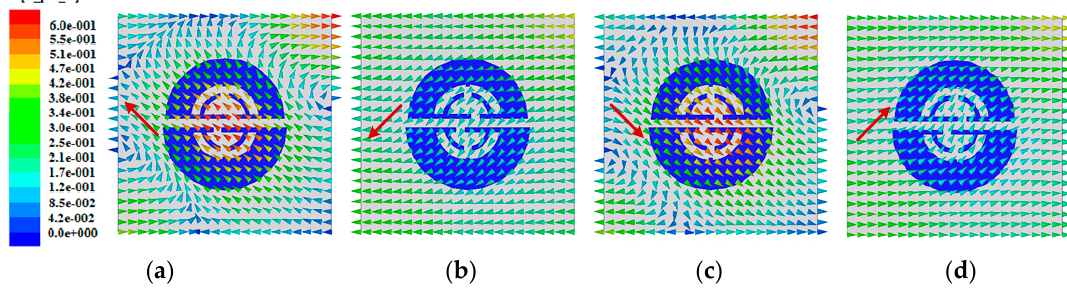
Figure 5. Magnetic field distributions for the polarizer validation from the waveguide model in Figure 4a. The surface magnetic field distributions on the top side of the model at 2.584 GHz are obtained for four different phase intervals: ( a ) 0°; ( b ) 90°; ( c ) 180°; and ( d ) 270°.